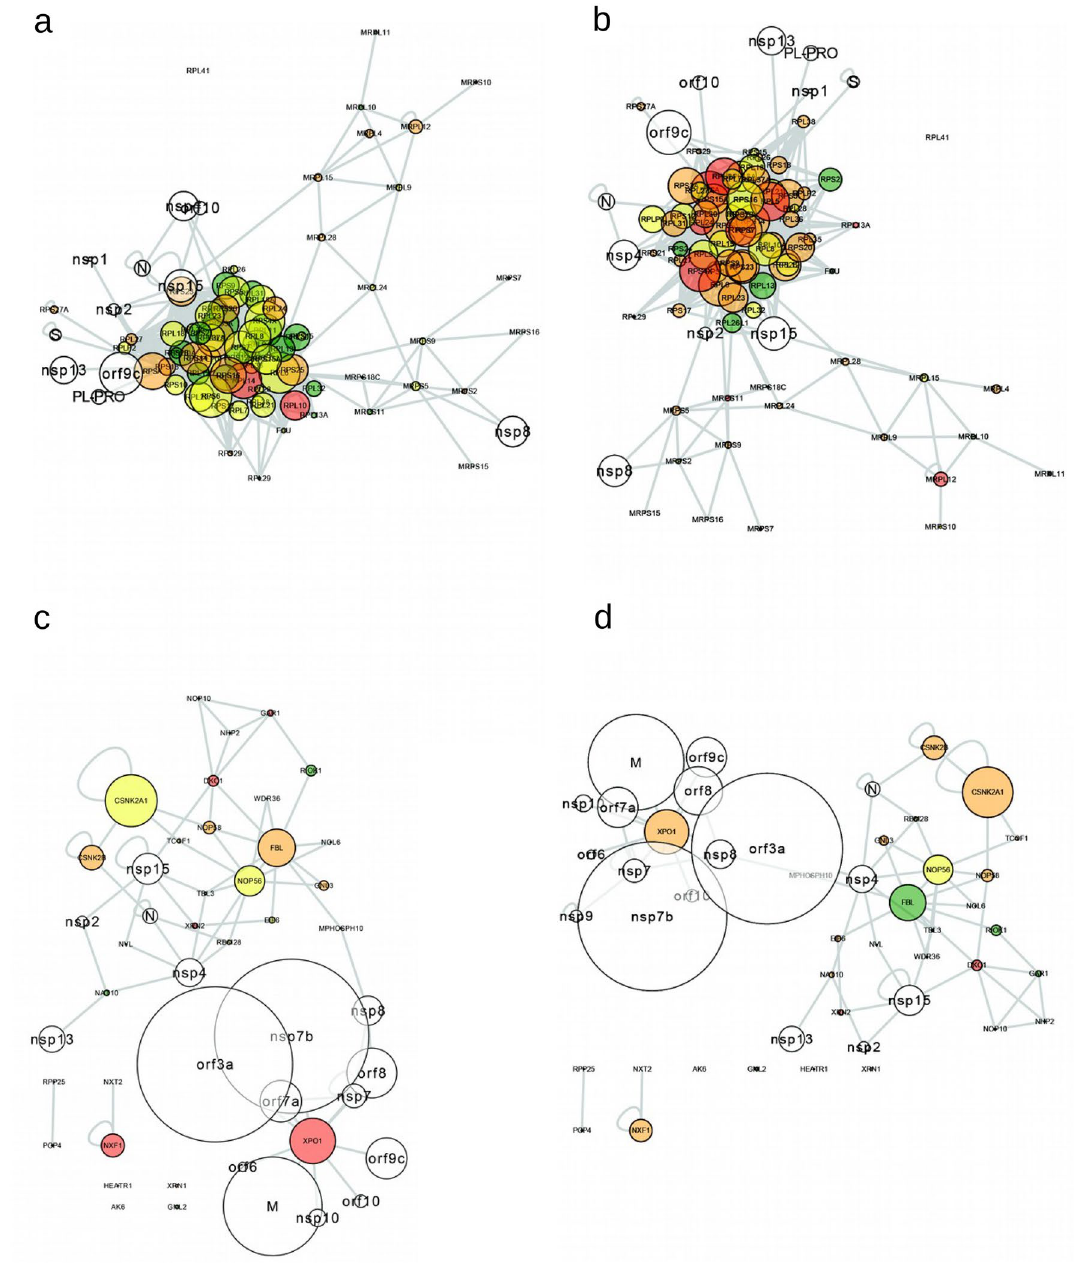
Figure 5. Specific networks. ( a , b ) ribosome pathway networks: ( c , d ) networks of the ribosome synthesis pathway. Lung (macrophages and pneumocytes), respectively. The color code and size nodes are the same as in Fig. 3. In the ribosome pathway there are 11 viral proteins (N, nsp4, PL-PRO, nsp2, nsp8, nsp13, orf9c, S, nsp1, orf10, and nsp15) that interact with proteins of this pathway. In Ribosome biogenesis in eukaryotes pathway there are 16 viral proteins (nsp7b, N, orf7a, nsp4, nsp2, nsp8, nsp13, nsp7, orf8, nsp10, orf9c, M, orf6, orf10, nsp15, and orf3a) that interact with proteins in this pathway; among them the 3 proteins with a high connectivity of SARS-CoV-2: M, nsp7b, and orf3a. These data are for the 2 cells shown. Similar results for kidney (cells in tubules) and small intestine (glandular cells) are present in Supplementary Fig.